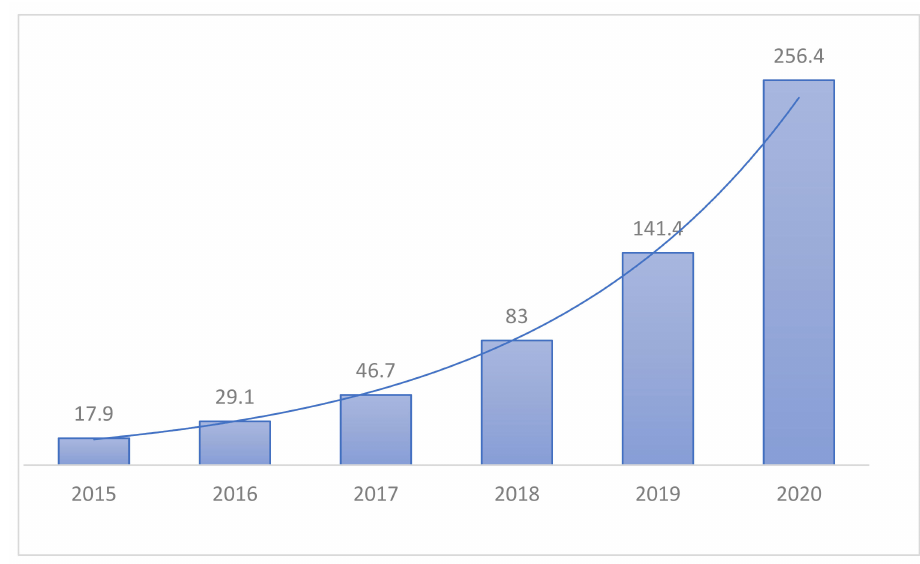
Figure 1. Forecast of the size of the healthcare market in Korea (KISTI Market Report).